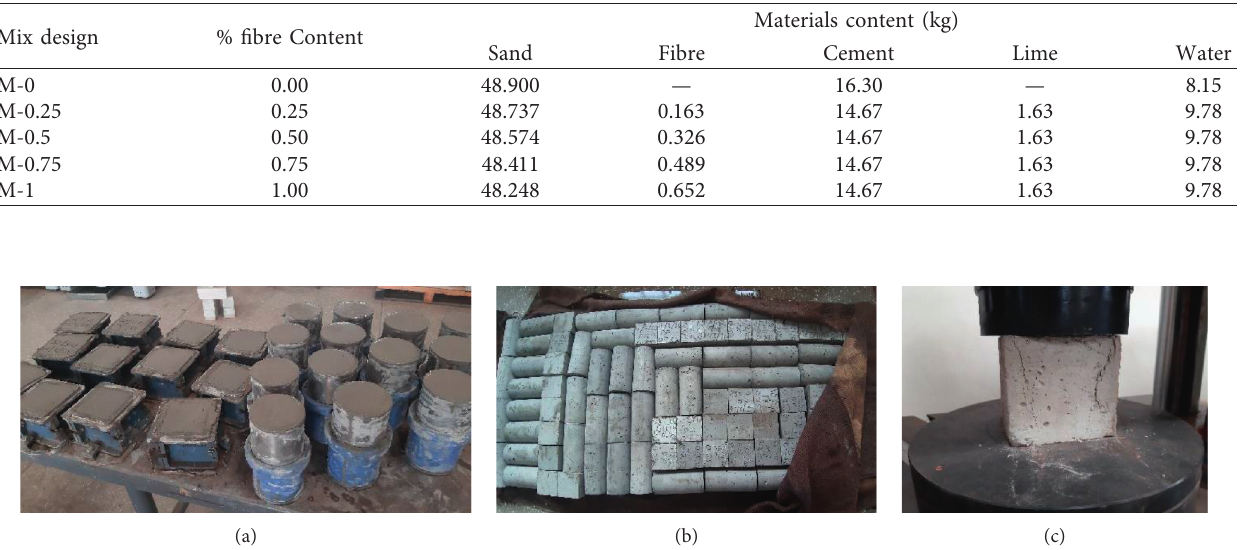
Table 1: Mix design and quantities of materials.